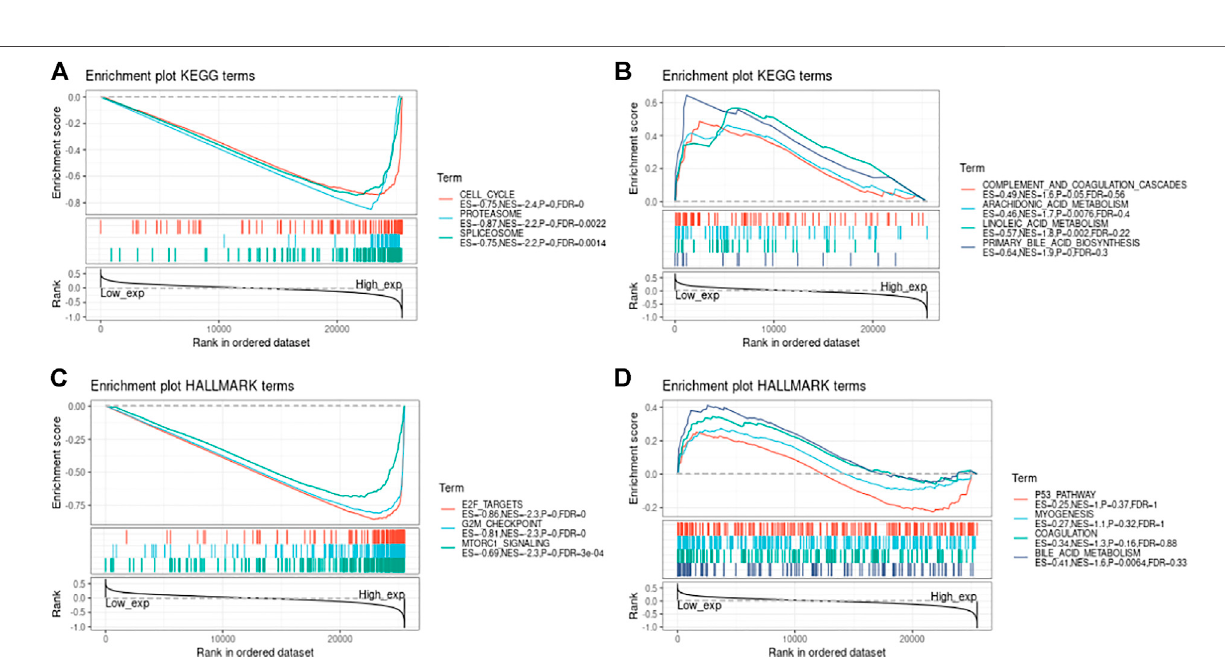
Frontiers in Genetics |